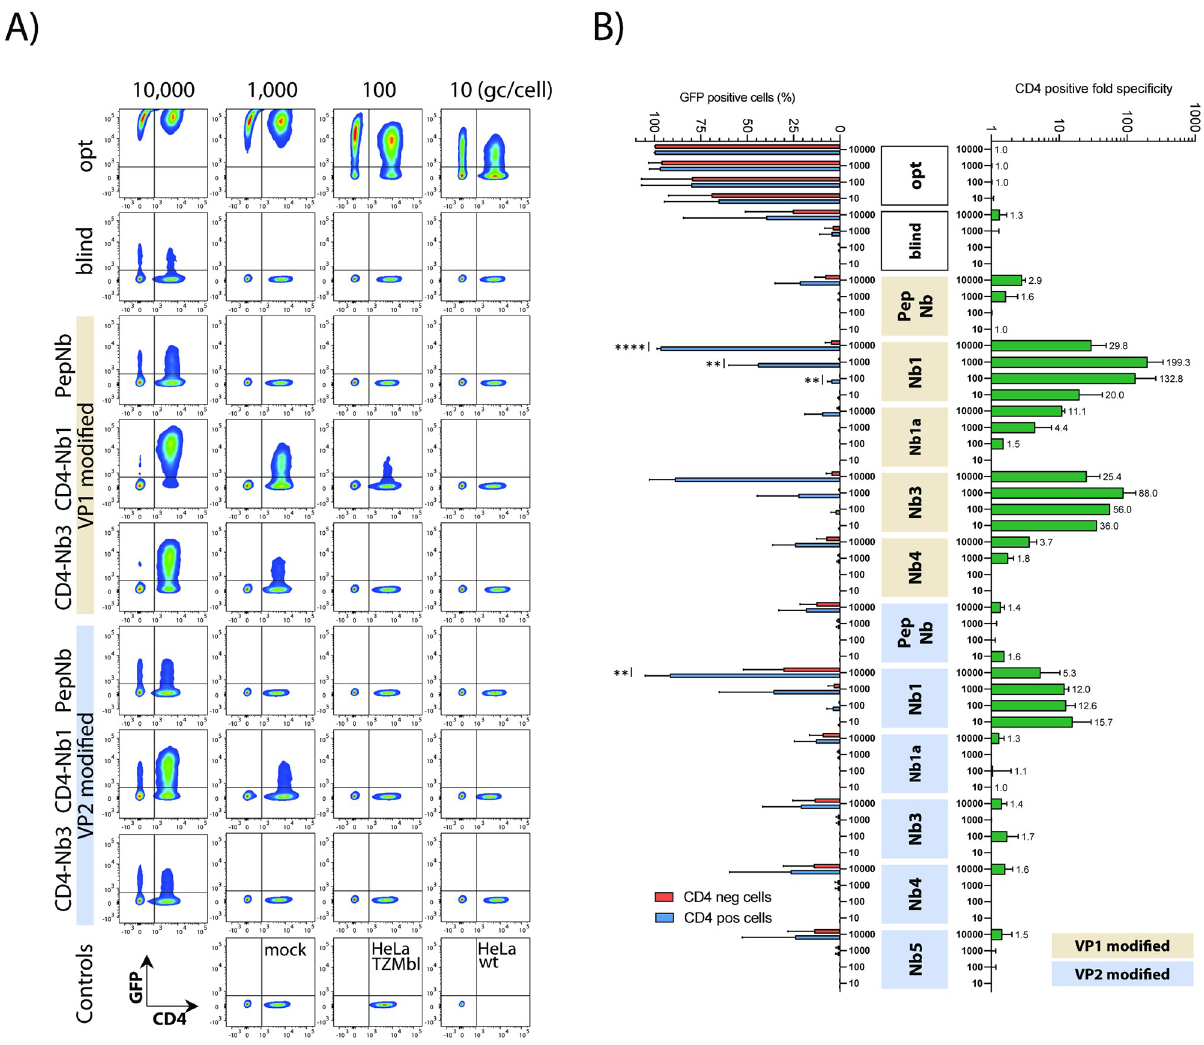
Fig 4. AAV2-CD4 Nb specificity in mixed culture experiments. (A) Representative analysis of a mixed culture experiment. HeLa wt (CD4 negative) were mixed with HeLa TZMbl (CD4 positive) in a ratio of 1:1 prior to AAV2 transduction and subsequently transduced with different virus dilutions. Three days post transduction, cells were harvested, stained for CD4 and analyzed for GFP expression by flow cytometry. (B) Cumulative data from independent HeLa mixed culture experiments. Indicated are the relative frequencies of GFP positive cells for CD4 positive and negative cells (on the left). AAV2 CD4-specific transduction is calculated as ratio from the individual cell populations (fold CD4 positive over CD4 negative). Fold changes are indicated (on the right); n = 2–6, presented are means with SD, significant differences indicated with asterisks: � p < .05, �� p < .01, ��� p < .001, ���� p <